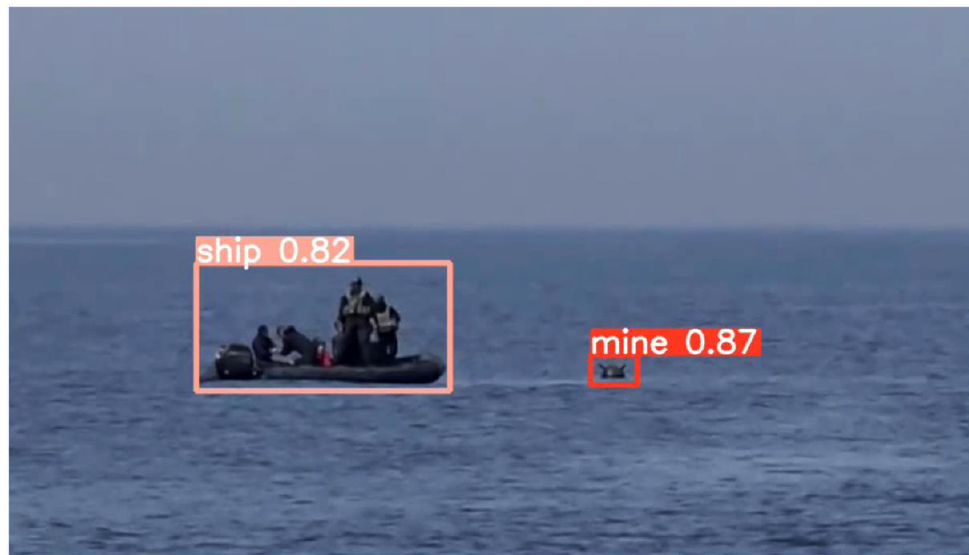
Figure 22. Ship and mine detection using Raspberry Pi and YOLO